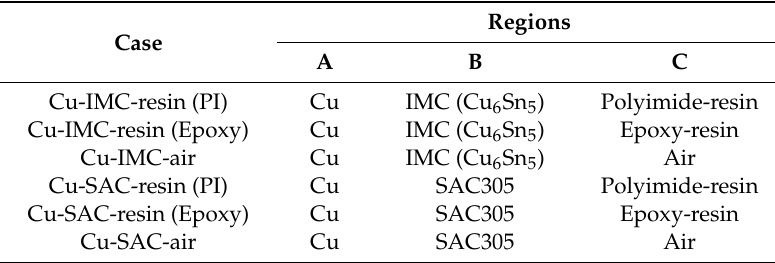
Table 1. FE analysis by 15- µ m-sized model.